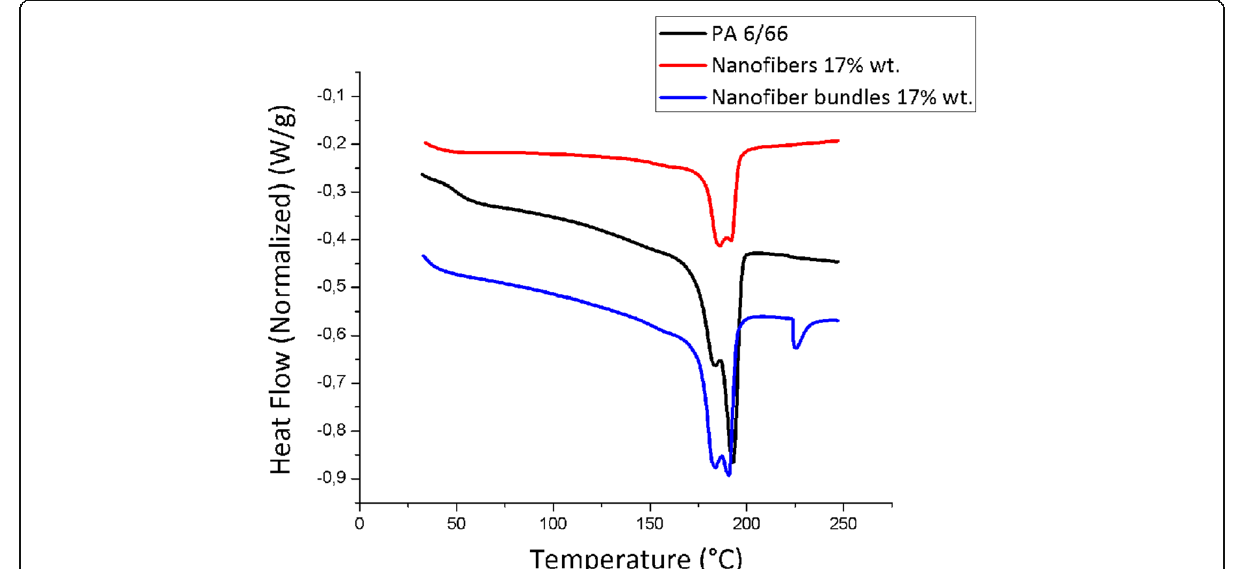
Fig. 8 Resulting optimal condition nanofiber bundle thermograms obtained through DSC